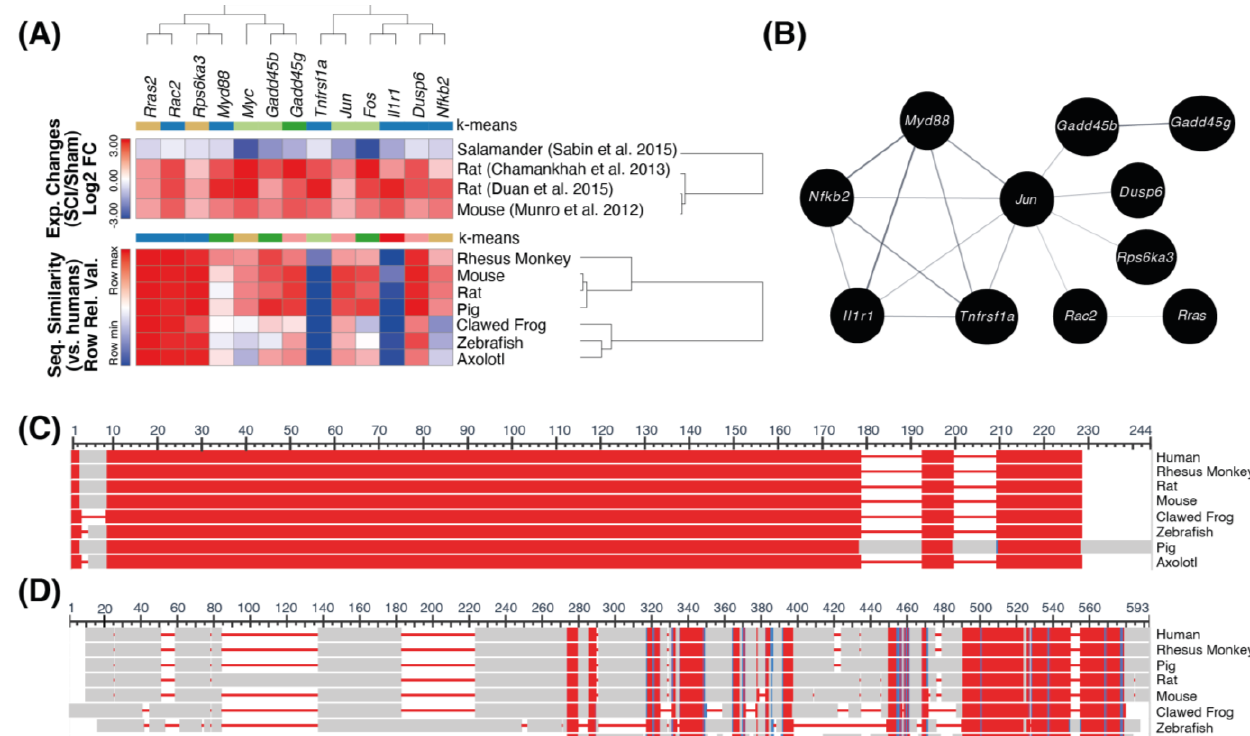
Figure 4. KEGG pathway enrichment analysis of orthologs with an opposite direction of expression in salamanders at 3 dpi. ( A ) Heatmap illustrating the MAPK signaling (KEGG ID: mmu04010) genes that contain the highest number of DEGs with opposing directionality in salamanders ( p -adj. = 6.01 × 10 − 5 , ES score = 4.22). Only orthologs that were expressed in all four studies were included in the heatmap. Mus musculus was used as the reference organism. Species were hierarchically clustered based on the cosine similarity metric of the average linkage method. Genes were divided into four groups based on the one minus cosine similarity method of K-Means clustering. Additionally, the genes were ordered according to evolutionary distances as determined by the phylogenetic tree, which was constructed via the neighbor-joining method in MEGA X. Only genes that were significantly differentially expressed after SCI ( p -adj. ≤ 0.05) in all four studies are represented. The bottom heatmap compares the relative amino acid percent sequence identity of each gene across species commonly used in SCI studies. K-means based on cosine similarity was used to classify the bottom heatmap into six groups. ( B ) The protein-protein interaction for eleven of the SCI-induced DEGs with opposite directions of expression in salamanders. ( C , D ) COBALT amino acid sequence alignment of Rras2 and Tnfrsf1a, respectively. Conserved amino acid sequences are shown based on the relative entropy threshold of the residue. Red indicates high conservation and blue indicates lower conservation, whereas grey indicates amino acids in positions that are not conserved. Only regions with no gaps are colored.